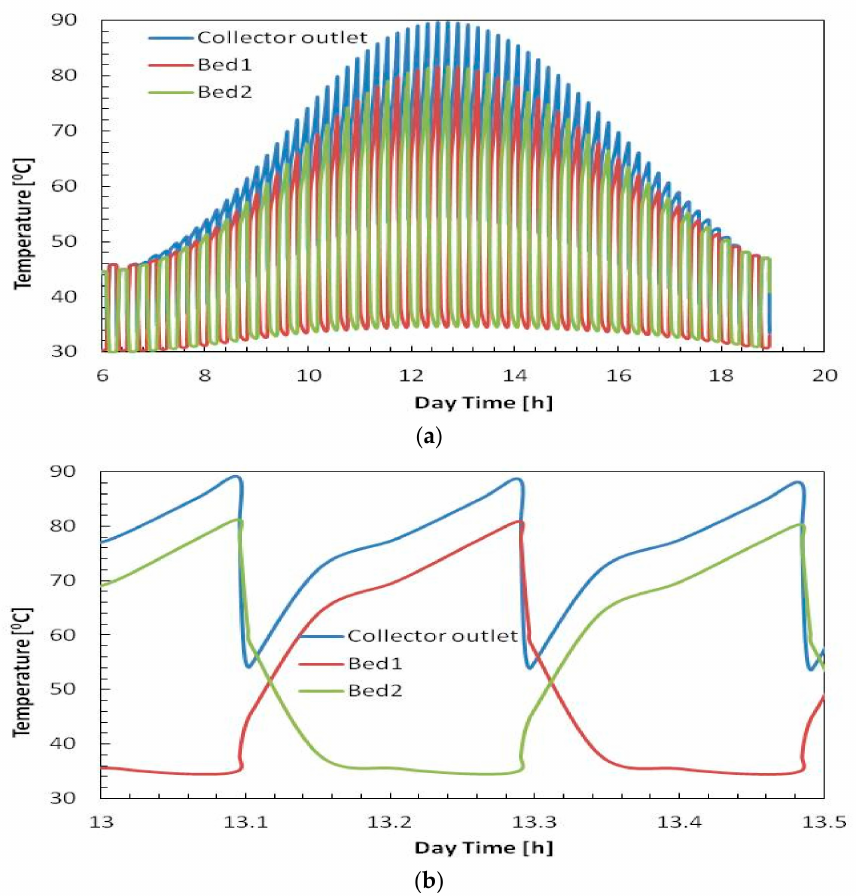
Figure 5. Temporal histories of hot water temperature at the outlet of the solar collectors and beds for a cyclic time of 1500 s, ( a ) day time; ( b ) peak